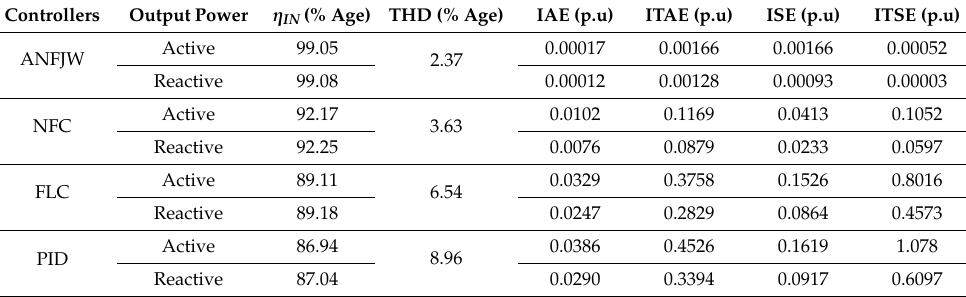
Figure 19. Dynamic performance comparison using reactive power: ( a ) IAE, ( b ) ITAE, ( c ) ISE, and ( d ) ITSE. Table 2. Comparison of efficiencies and dynamic response.